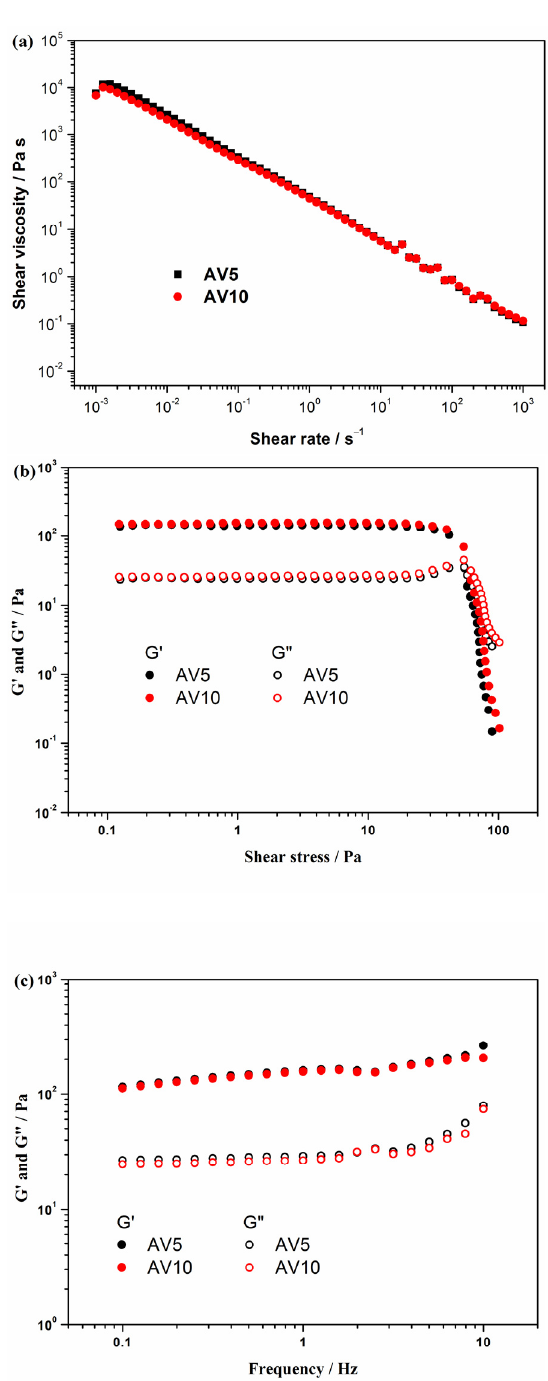
Figure 2. ( a ) Shear viscosity vs. shear rate of the AV5 and AV10 samples; ( b ) Storage (G’) and loss (G”) moduli as a function of shear stress at 1 Hz for AV5 and AV10 samples; ( c ) Storage (G’) and loss (G”) moduli as a function of frequency at 5 Pa for AV5 and AV10 samples.